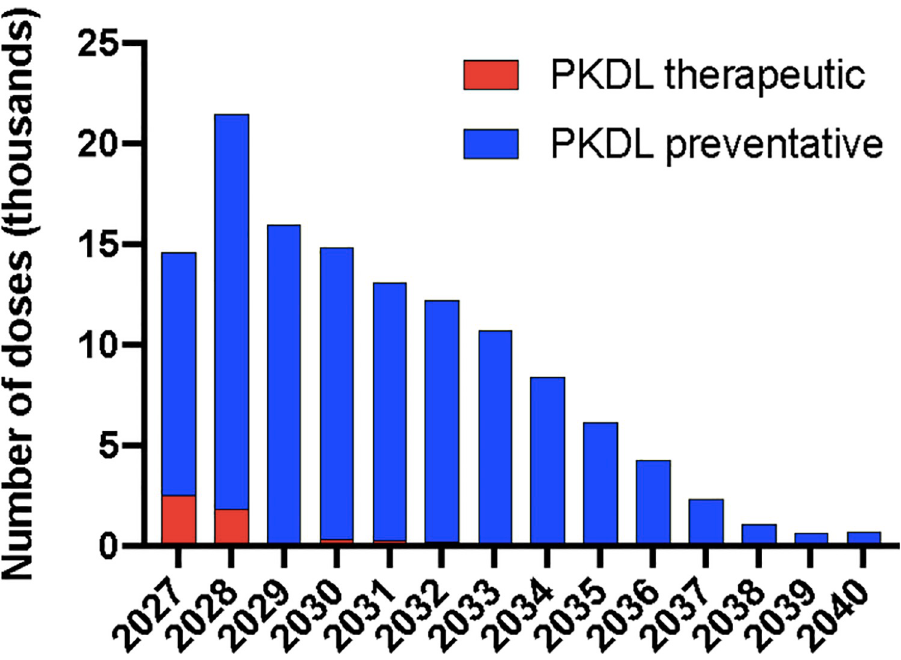
Fig 4. Vaccine demand–total number of yearly doses required at global level for a vaccine with PKDL therapeutic and preventative indications (in the scenario of a vaccine with VL indication also being available).